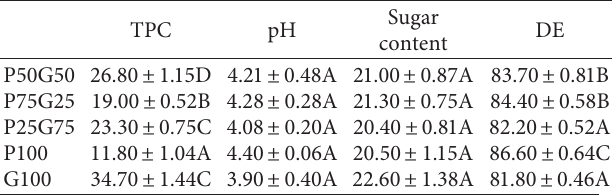
Table 2: The effects of pectin: gum ratio on the total phenol content, pH, sugar content, and DE of